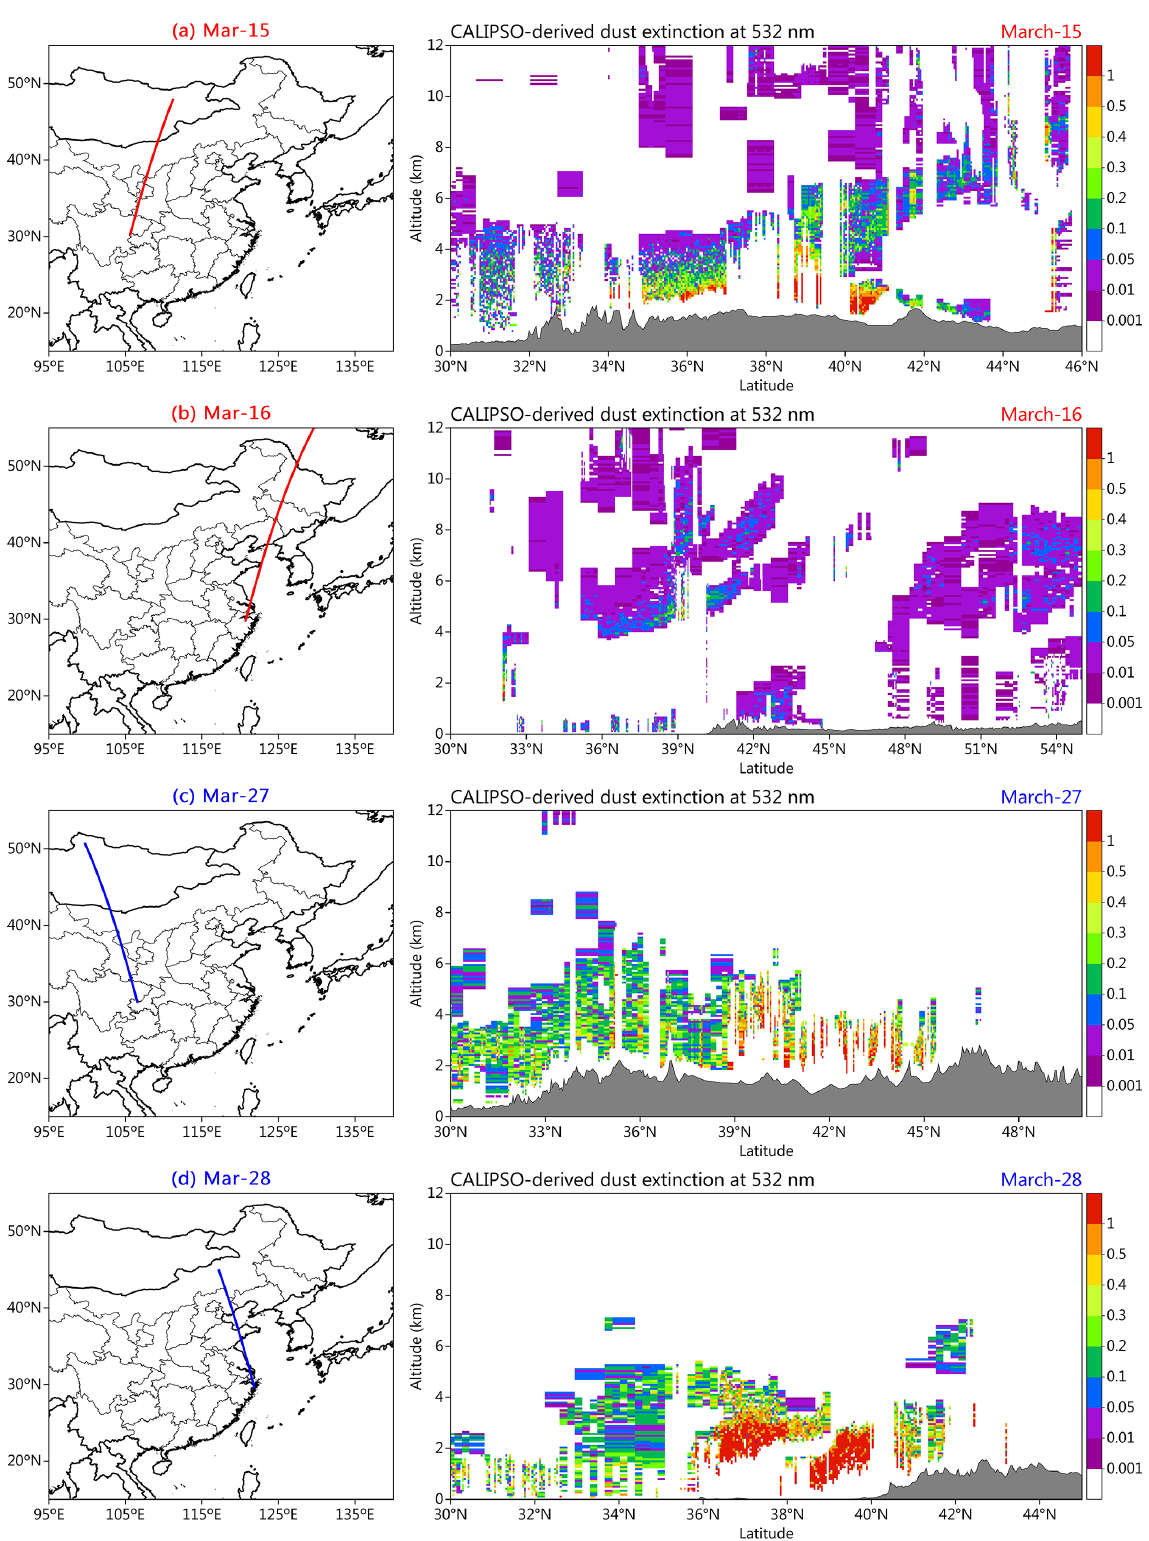
Figure 8. CALIOP/CALIPSO snapshots of dust plumes for (a) 15, (b) 16, (c) 27, and (d) 28 March 2021. The first column presents the CALIPSO tracks (red or blue lines) and the second column shows the 532nm dust extinction coefficients (km − 1 ). Surface elevation is indicated by the gray filled